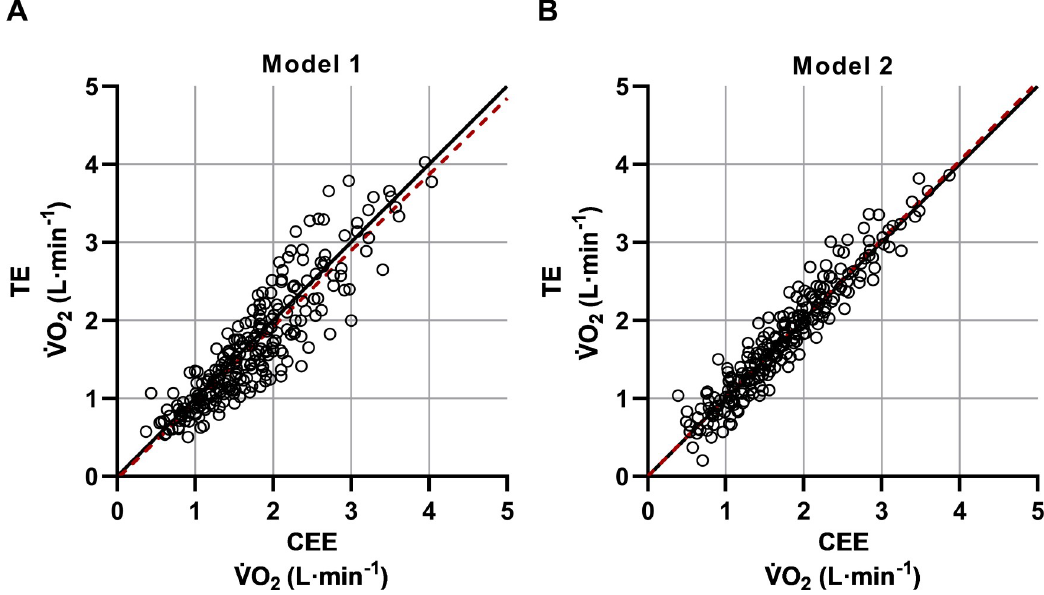
Fig 3. Comparison of the estimated individual _ V _ O values between cycle ergometer exercise (CEE) and treadmill exercise 2 (TE) in model 1 and model 2. Based on all participants (n = 34), ranging between 25–85% of HRR. The overall linear regression equations (red dashed lines) with 95% CI and r-coefficients were: Model 1 (A) y( _ V _ O TE) = -0.033(-0.148 ─ 0.082) + 0.9753 2 (0.9144 ─ 1.0362) � x( _ V _ O CEE) and r-coefficient = 0.899. Model 2 (B) y( _ V _ O TE) = -0.004(-0.081 ─ 0.073) + 1.0125(0.9714 ─ 1.0536) 2 2 � x( _ V _ O CEE) and r-coefficient = 0.953. 2